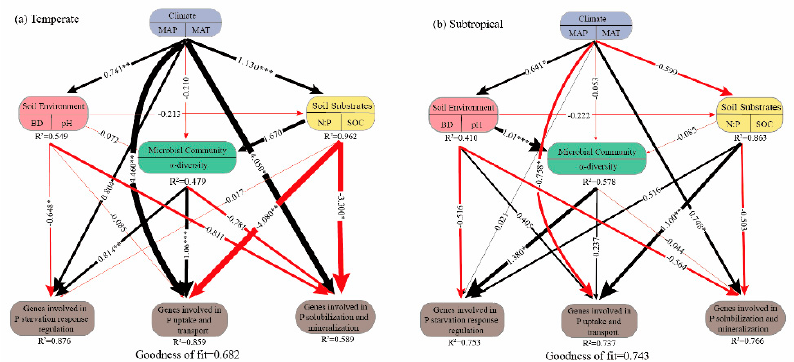
Figure 4. Partial least squares regression (PLS-PM) modeling variables effects on phosphorus func- tional genes in temperate and subtropical forest biomes. Partial least squares regression analysis was conducted for direct and indirect effects of biotic and abiotic factors on phosphorus functional genes. Single-headed arrows indicate the hypothesized direction of causation. Black solid and red solid arrows indicate positive and negative relationships, respectively. Dashed arrows indicate in- significant relationship ( p ≥ 0.05). The arrow width is proportional to the strength of the relationship. Double-layer rectangles represent the component of biotic and abiotic factors to phosphorus cycle functional genes. The climate includes MAP and MAT; the soil substrates include the SOC and N/P ratio; soil environment represents BD and pH; microbial community ( α -diversity). The numbers adjacent to the arrows are the standardized path coefficients. * p < 0.05, ** p < 0.01, and *** p < 0.001. The GoF values were 0.682 in temperate zones and 0.743 in subtropics in abundance of phosphorus functional genes.